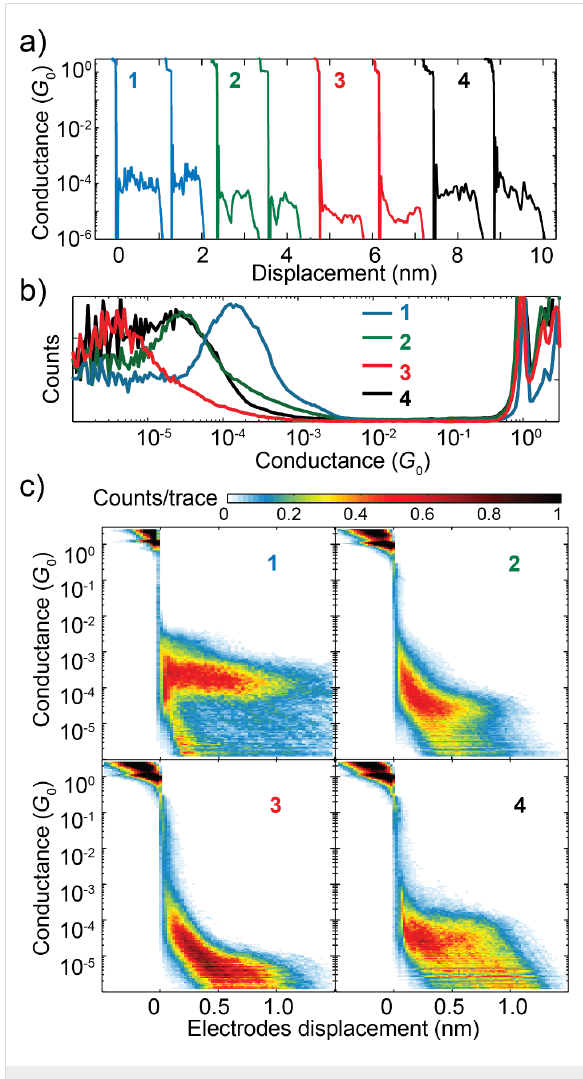
Figure 3: (a) Individual breaking traces in presence of the molecules 1 – 4 . The applied bias is 0.1 V and the electrode retraction speed is 5 nm/s. The traces are offset along the x-axis for clarity. (b) Conductance histograms built from more than 2000 breaking traces recorded in presence of the molecules 1 – 4 . The breaking traces have been logarithmically binned, in the conductance axis, with 30 bins/decade. (c) Conductance–distance histograms built from the breaking traces of molecules 1 – 4 . The displacement axis has been binned with 45 bins/nm.